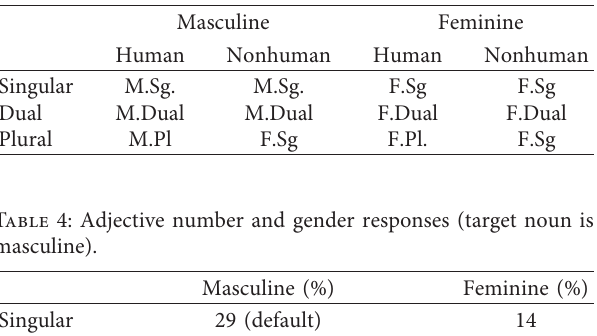
Figure 5: Mean % correct for singular, dual, and plural adjective inflection for HP. Table 3: Schematic illustration of adjectival agreement paradigm in modern standard Arabic.